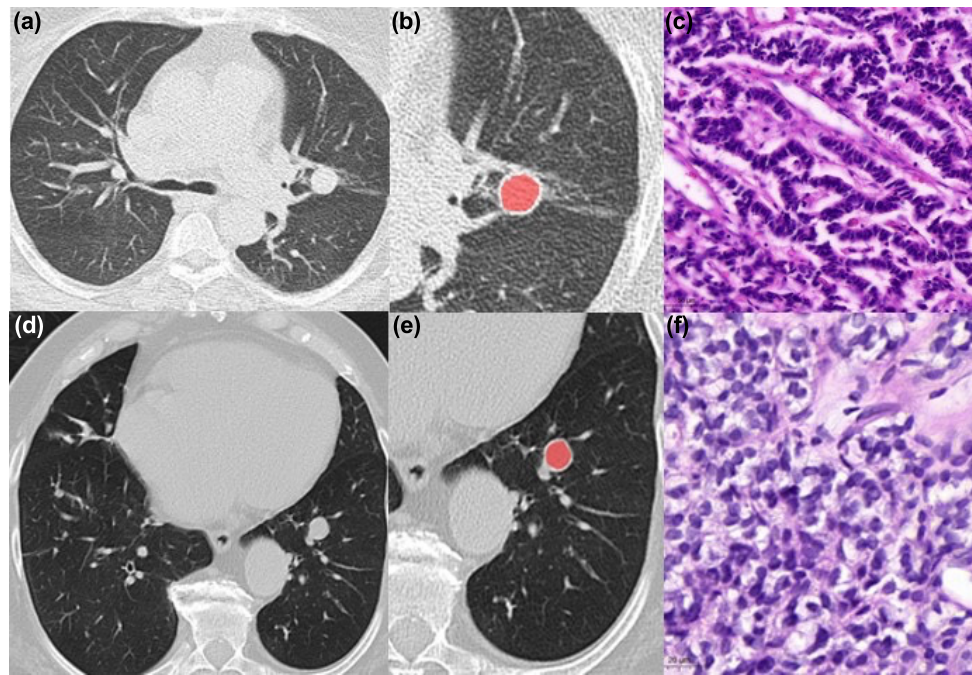
Figure 1. Representative cases of the patient sample with a typical carcinoid ( a – c ) and atypical carcinoid ( d – f ). Typical carcinoid is located centrally in the left upper lobe. The corresponding Ki-67 index was 1%. The region of interest of this tumor is drawn within the tumor boundaries ( b ). Histopathological image of the typical carcinoid (hematoxylin eosin stain) is shown in panel ( c ). Another representative case of the patient sample with an atypical carcinoid located centrally in the left lower lobe ( d – f ). The corresponding Ki-67 index was 5%. The region of interest of this tumor is drawn ( e ). Histopathological image of the atypical carcinoid (hematoxylin eosin stain) is shown in panel ( f